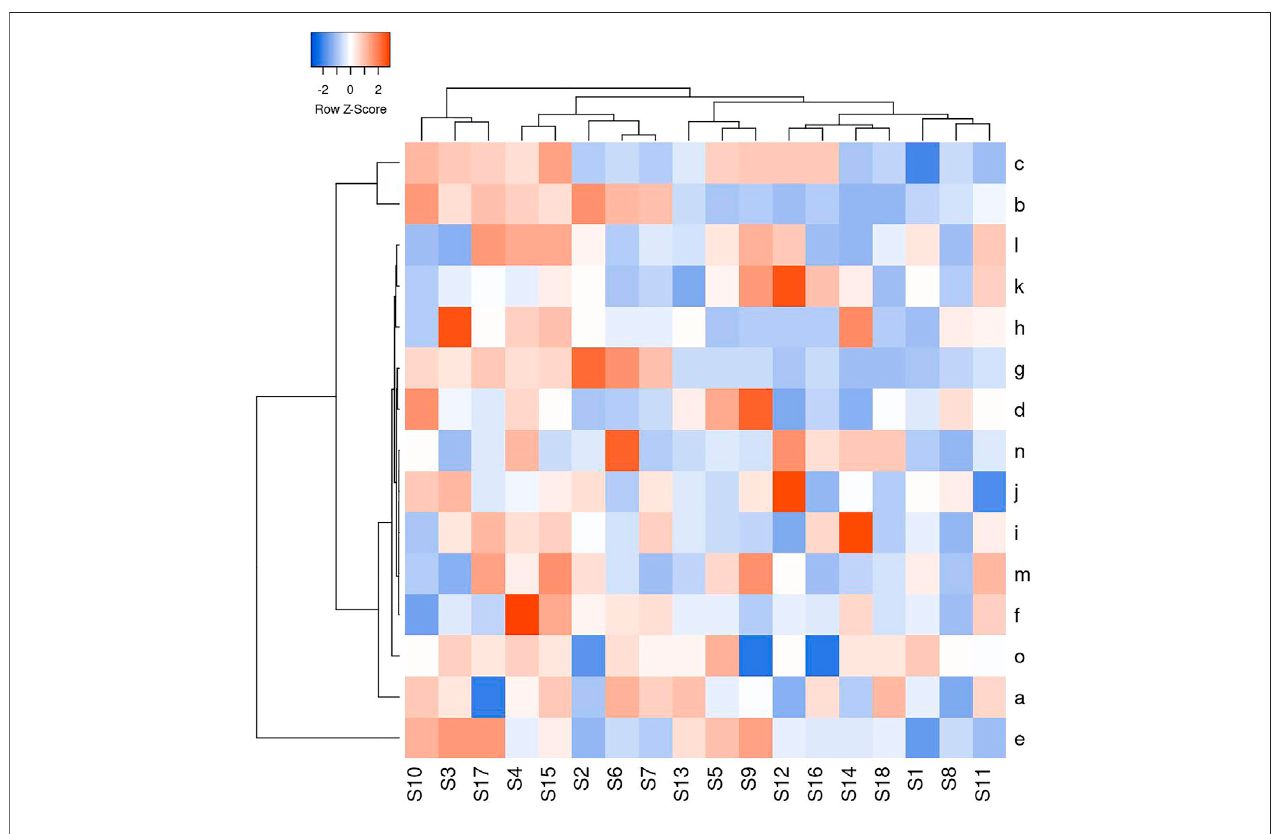
FIGURE 4 | HCA heat map for 18 BBTD samples and 15 chemical compounds.